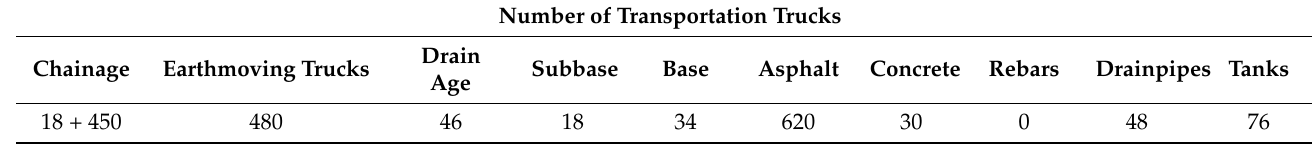
Table 3. Required movements for chainage 18 +